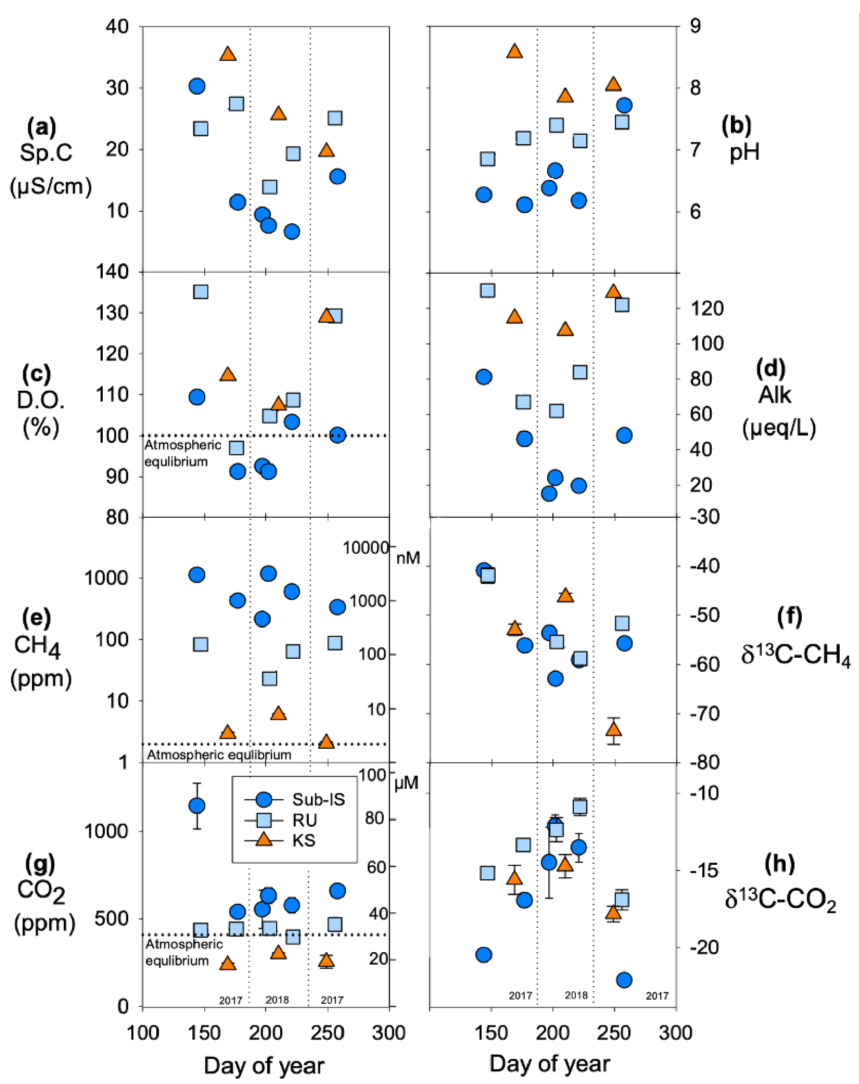
Figure 3. Chemical parameters at sub-Isunnguata (sub-IS), Russell (RU), and Kiattut Sermiat (KS) subglacial water sampling sites versus day of year for (a) specific conductivity (Sp.C), (b) pH, (c) dissolved oxygen (D.O.) percent saturation, (d) alkalinity (Alk), (e) measured CH 4 concentrations (left y axis in ppm and right y axis in nM), (f) δ 13 -CH 4 values, (g) measured CO 2 concentrations (left y axis in ppm and right y axis in µM), and (h) δ 13 C-CO 2 values. Atmospheric equilibrium concentrations are indicated by dashed lines and taken as 1.9ppm for CH 4 and 410ppm for CO 2 . Error bars on CH 4 and CO 2 concentrations and stable isotopic compositions represent the standard deviation of replicates and are smaller than symbols for some data